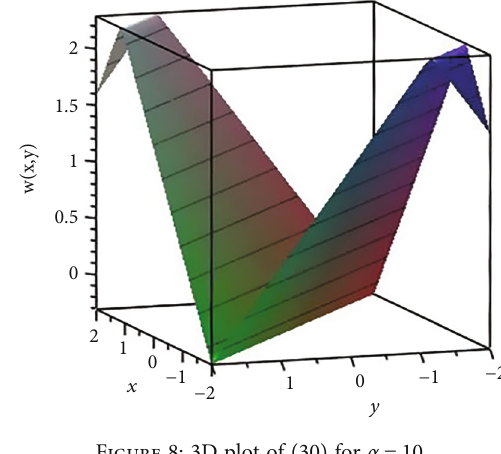
Figure 6: 3D plot of (24) for x = 1 .